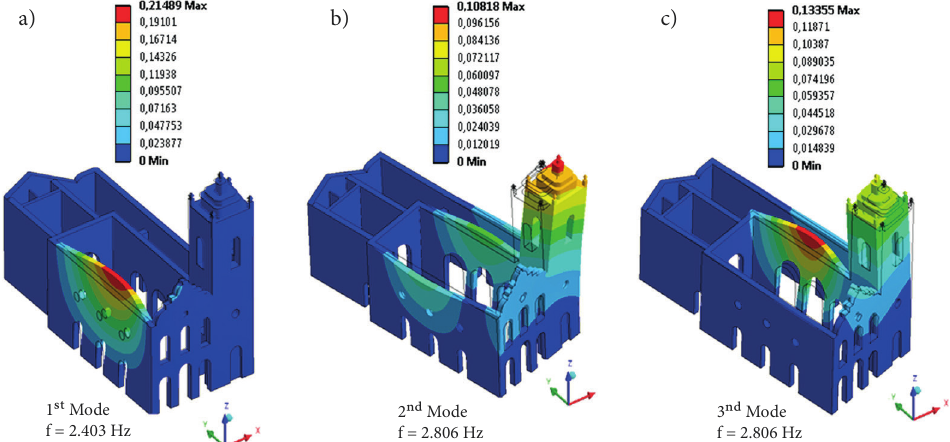
Fig. 13. First three modal shapes of the Nossa Senhora das Dores Church